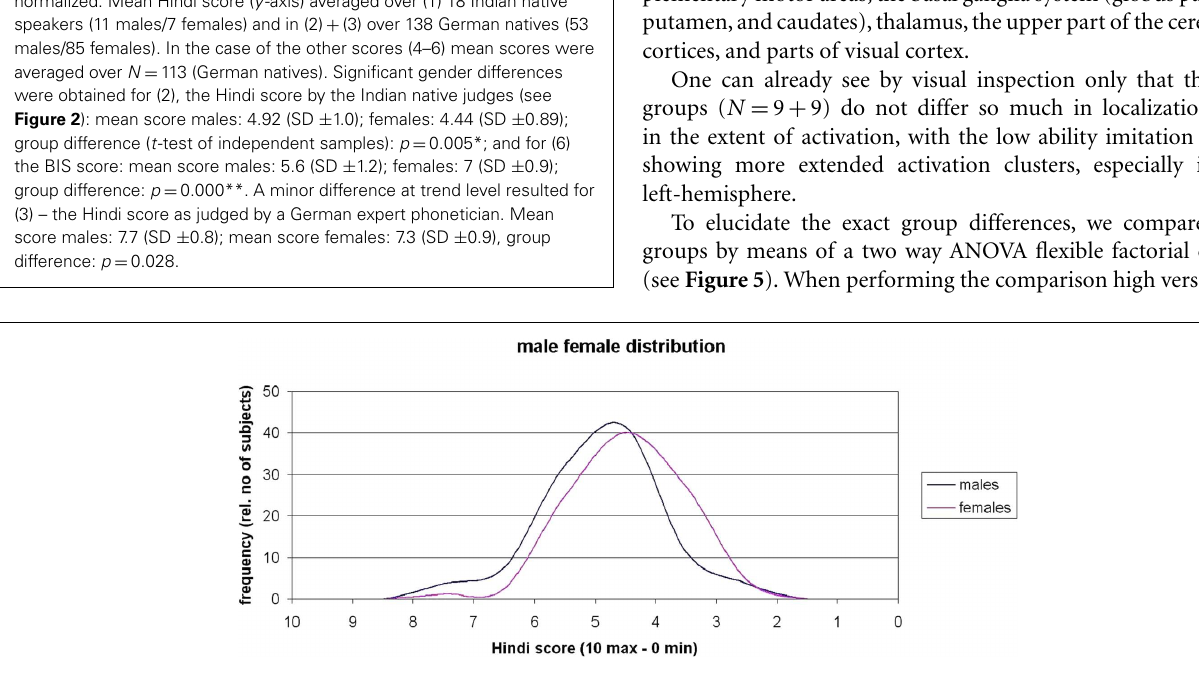
FIGURE 4 | Gender differences distribution: this figure shows the score distributions of mimicking capacity of the Hindi sentences, separately for males and females. The distribution curve of the females is shifted slightly toward the lower score range, whereas the males’ distribution is shifted toward the higher scores. Scores as rated by native Hindi speakers are provided on the x -axis, relative number of participants (frequency) is given on the y -axis.